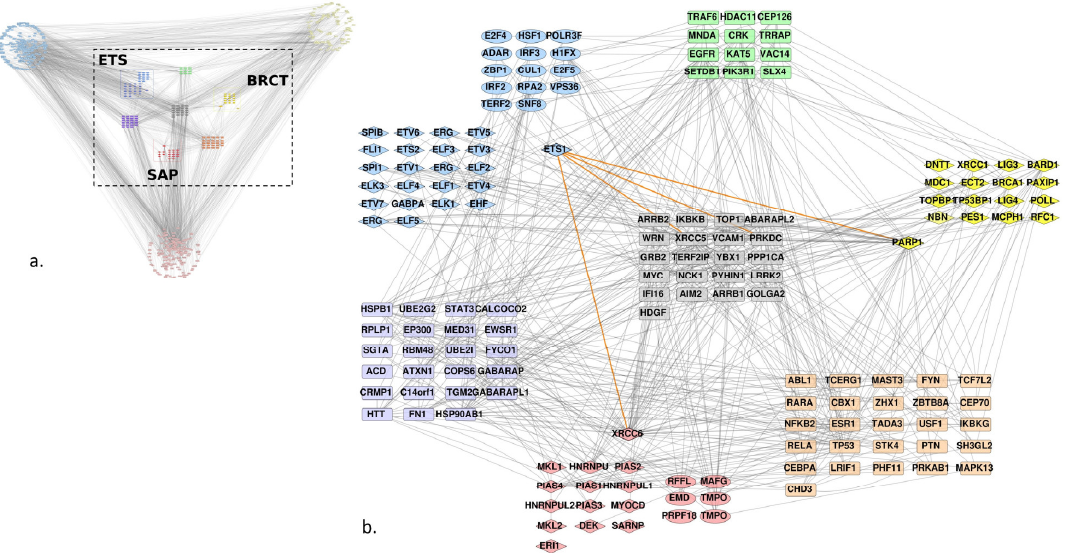
Figure 2. Human protein-protein interaction (PPI) network of Ets-1, PARP-1, Ku70, and proteins that bear a domain homolog to the ETS domain of Ets-1, BRCT domain of PARP-1 and SAP domain of Ku70. ( a ) Global first neighbor PPI network; ETS homologs are colored blue, BRCT homologs are colored yellow and SAP homologs are red; first neighbors of ETS, BRCT and SAP homologs are shown at the extremities of the graph and plotted in another shade of blue, yellow and red, respectively; common interactors between different types of homologs are colored in a mix of colors of the homologs, resulting in green for ETS and BRCT, purple for ETS and SAP, and orange for SAP and BRCT; proteins that interact with at least one protein of each group of homologs are colored grey. ( b ) Central network delimited by the dashed square in ( a ), only interactors that are shared between at least two groups are conserved; diamond forms are the proteins that were annotated by Interpro as containing a ETS, BRCT or SAP domain, ellipses are the additional homologs we have found, using our method; rounded rectangles are identified interactors; orange edges indicate known interactions with